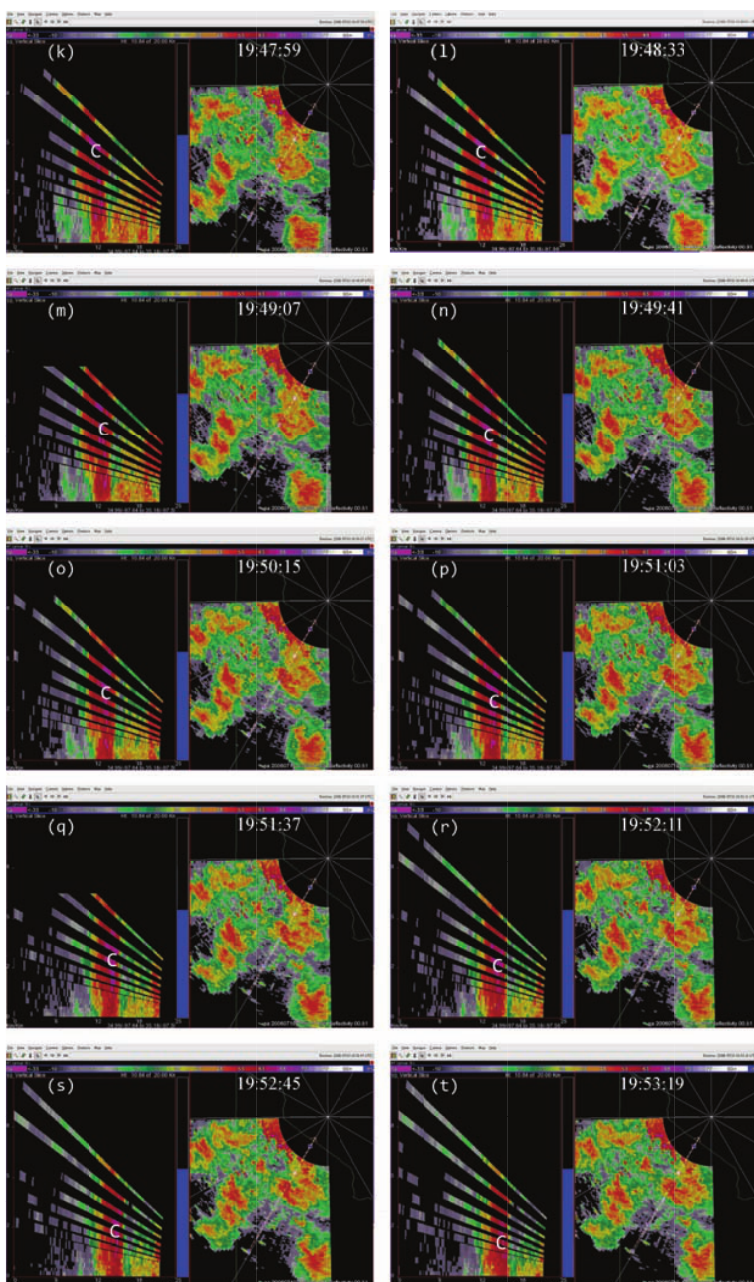
Figure 2: Reflectivity images from 20 consecutive PAR 90 ∘ sector scans of a severe microburst event from 19: 41:12 to 19 :53 : 19 UTC on July 10, 2006. Each panel consists of two subpanels: (i) the range height indicator (RHI) display along the 210.7 ∘ azimuth on the left side and (ii) the plan position indicator (PPI) display at 0.51 ∘ elevation on the right side. For the RHI display, the radial range is leftward from 𝑟 = 10 to 35 km and the height range is upward from 𝑧 = 0 to 10km. The horizontal (or vertical) domain used in the first (or second) step of retrieval is shown by the white dashed boundary lines in the right (or left) subpanel of panel (a). The white letter C in each left subpanel marks the reflectivity core. As shown from panel (a) to (t), the reflectivity core falls from 𝑧 ≈ 6 km to 1.8 km in 667 s, so the estimated falling speed of the reflectivity core is 𝑤 𝑚2 = (𝑤 𝑎 𝑚 + 𝑤 𝑇 ) ≈ (4.2km)/(667s) = 6.3 ms −1 , where 𝑤 𝑇 ( ≤ 0) is the hydrometeors’ terminal velocity as defined in